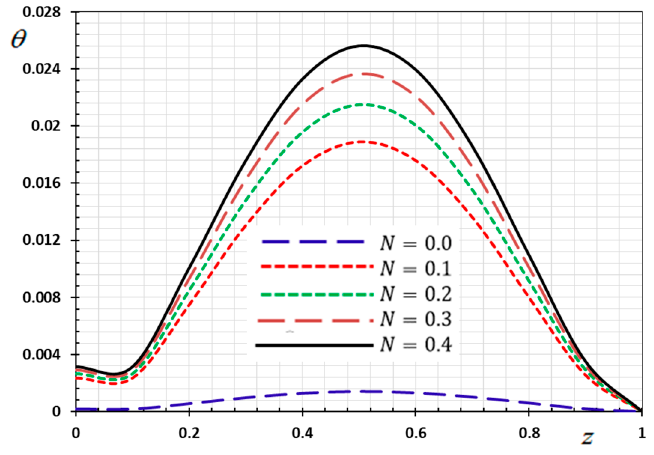
Figure 9. Variation of temperature 𝜃 versus 𝑧 for different gradient coefficient 𝑁 .